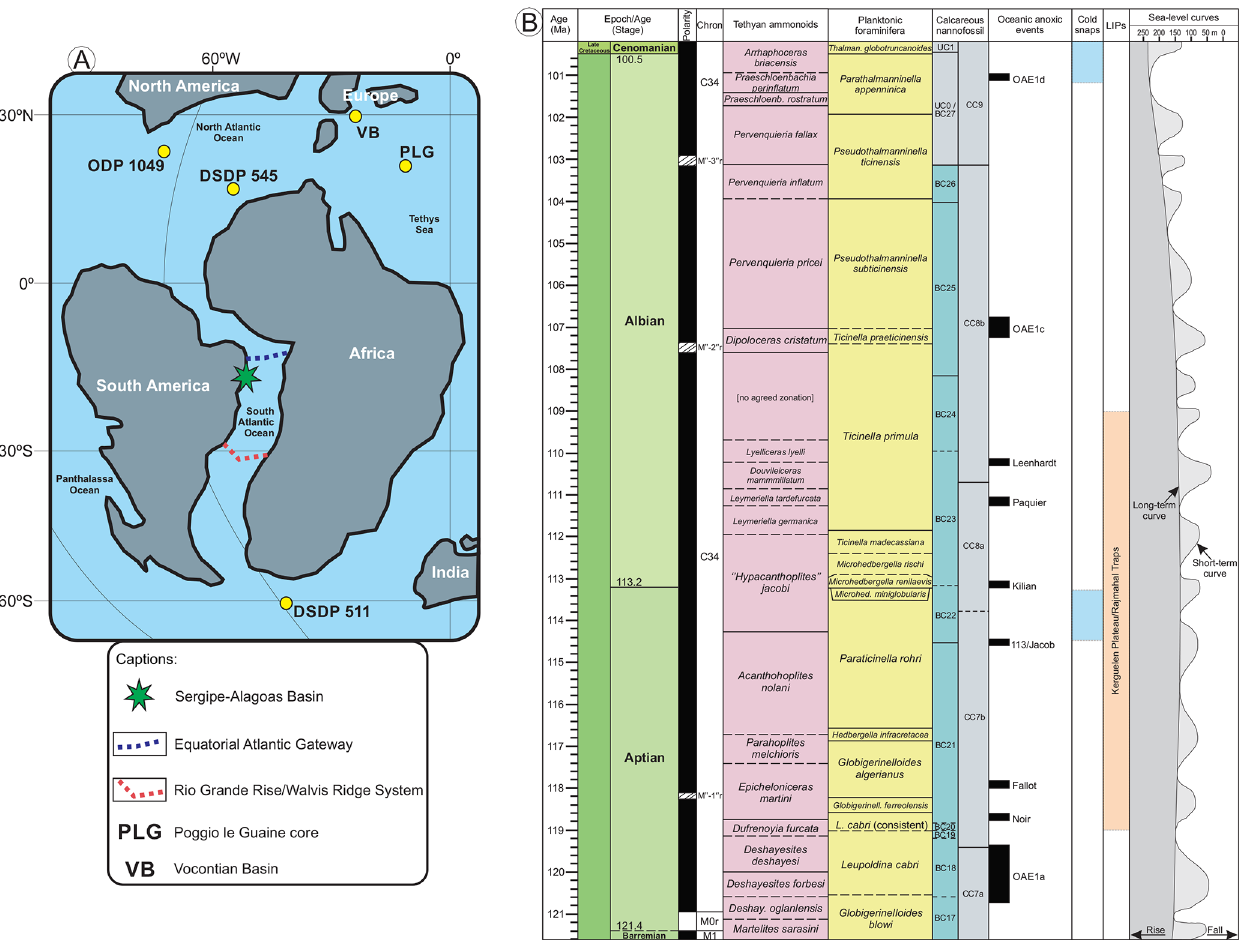
Figure 1. (a) Paleogeographic reconstruction at 112Ma (modified after Hay et al., 1999) showing the location of the Sergipe–Alagoas Basin, the Equatorial Atlantic Gateway, the Rio Grande Rise–Walvis Ridge System, the Vocontian Basin (VB), the Poggio le Guaine (PLG) core, and the Deep Sea Drilling Project (DSDP) and Ocean Drilling Program (ODP) sites containing the Aptian–Albian boundary. (b) Stratigraphic chart of the drilled section with biostratigraphic zones for ammonoids, planktonic foraminifera, and calcareous nannofossil (Gale et al., 2020). For this interval, the main ocean anoxic events (Gale et al., 2020), cold snaps (Hu et al., 2012), large igneous provinces – LIPs (Courtillot and Renne, 2003), and sea level curves (Haq, 2014) are also